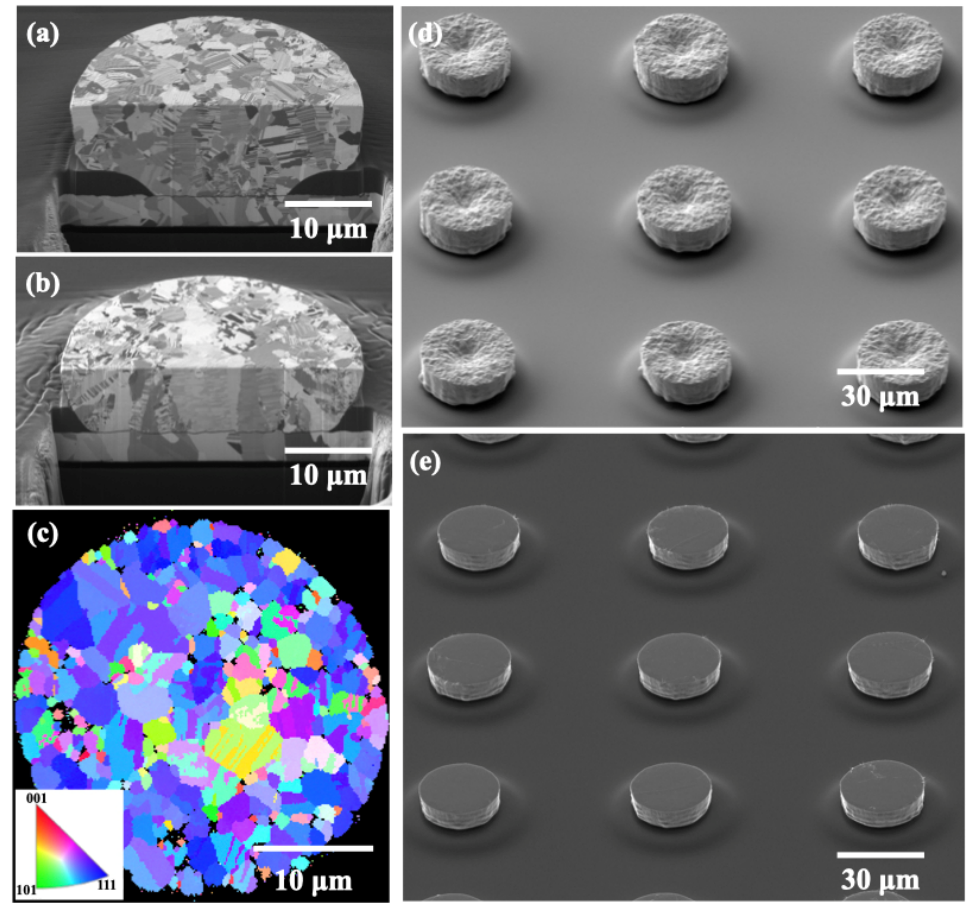
Figure 3. Cross-sections of ( a ) top die and ( b ) bottom die microbumps were analyzed by FIB. ( c ) Bonding surface orientation in normal direction of the nt-Cu microbumps analyzed by EBSD and calculated by OIM in around 40% of <111>-preferred orientation. ( d ) Cu microbumps before CMP. ( e ) Cu microbumps after CMP.